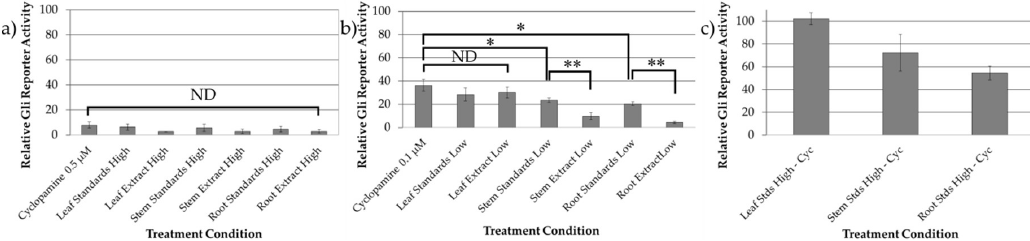
Figure 2. Bioactivity data for cyclopamine alone, the alkaloid standard mixtures, and the plant extracts at ( a ) high concentration (0.5 µ M) and ( b ) low concentration (0.1 µ M). No significant difference was observed between treatment conditions at high concentration. Statistically noteworthy differences were observed in the low concentration treatments, and * indicates p < 0.05, and ** indicates p < 0.01. The inhibitory activity of veratramine, isorubijervine and muldamine in the absence of cyclopamine in the same concentrations as the high concentration treatment conditions is shown in ( c ).